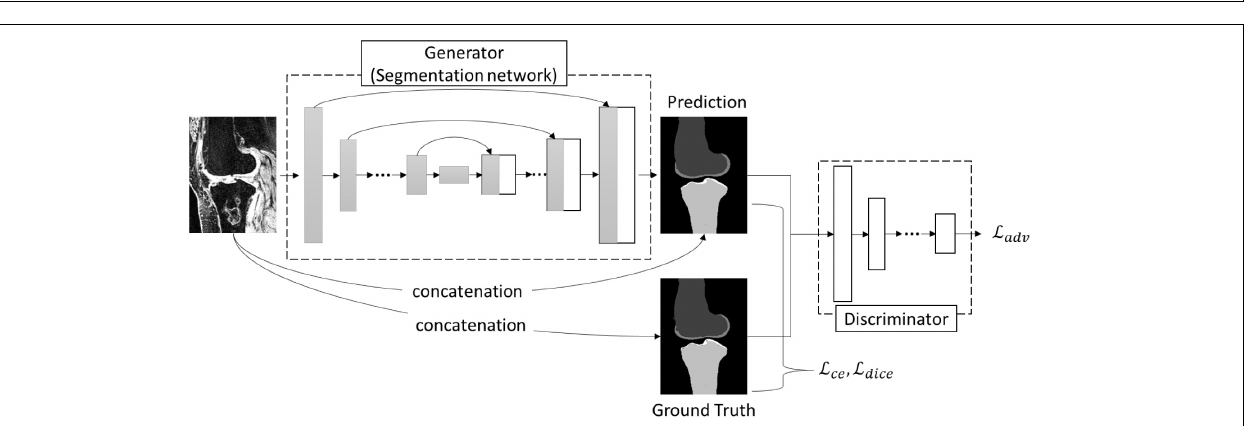
FIGURE 1 | Proposed workflow for the knee bone and cartilage segmentation.